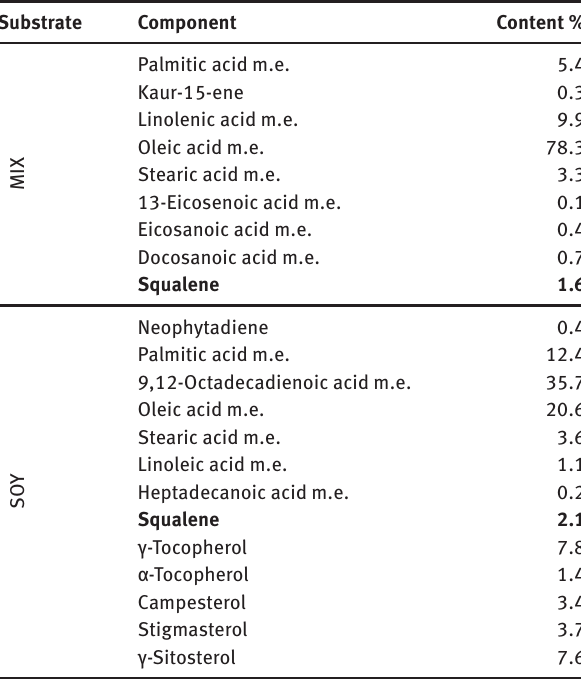
Table 1: Percentage composition of MIX and SOY.